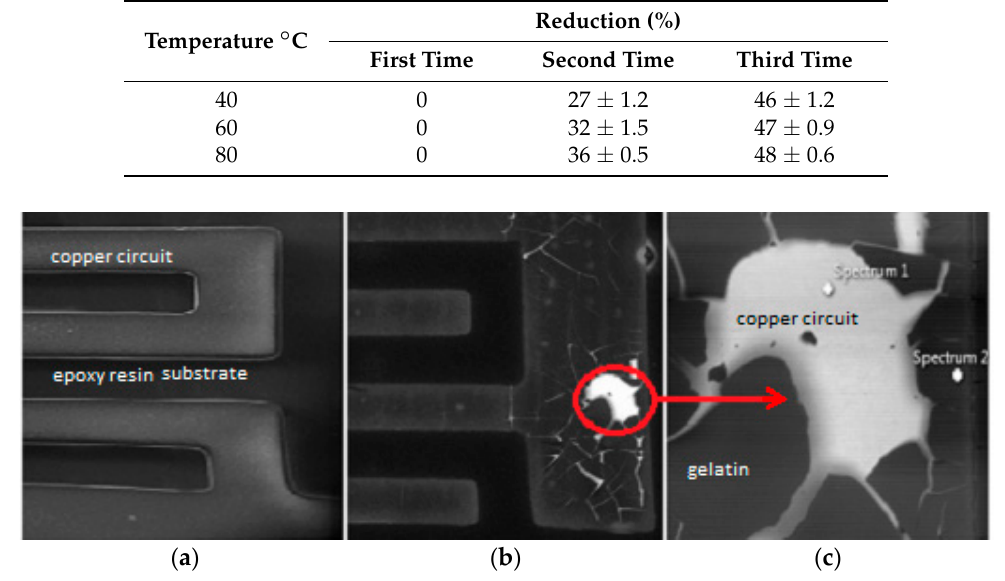
Figure 7. Images by SEM (scanning electronic microscopy) of the gelatin layer (38 µm) on the electrode: ( a ) electrode before use, 50×; ( b ) electrode after use, 50×; and ( c ) detail (400×) of the image from condition ( b ).